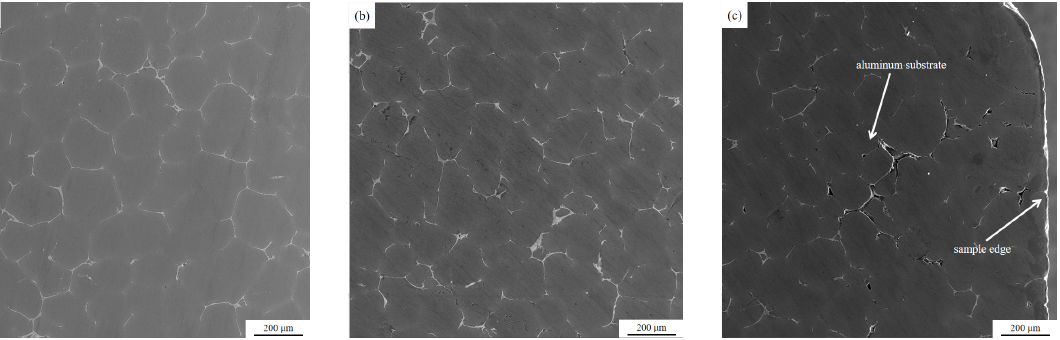
Figure 9. SEM image of the residual aluminum melt sample inside the post-ceramic cavity: ( a ) central area, ( b ) transition area, ( c ) marginal area.